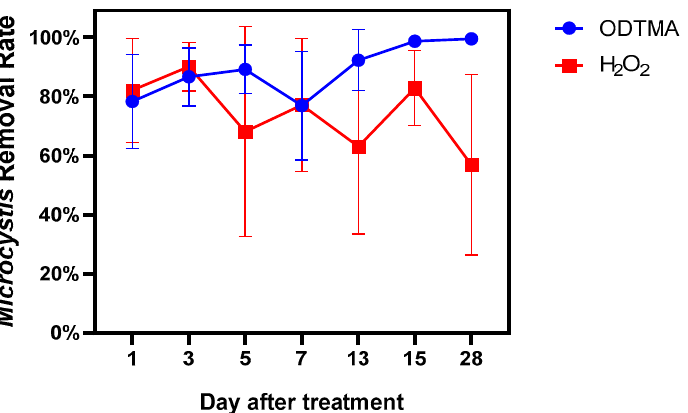
Figure 6. Removal rate of Microcystis cells during the 28-day mesocosm experiment. The initial cell density of Microcystis sp. was 1.83 × 10 6 cells/mL.